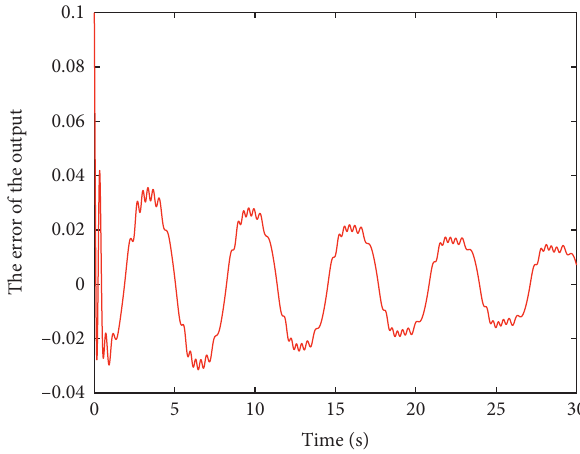
Figure 4: The errors of output with small input signal amplitude.